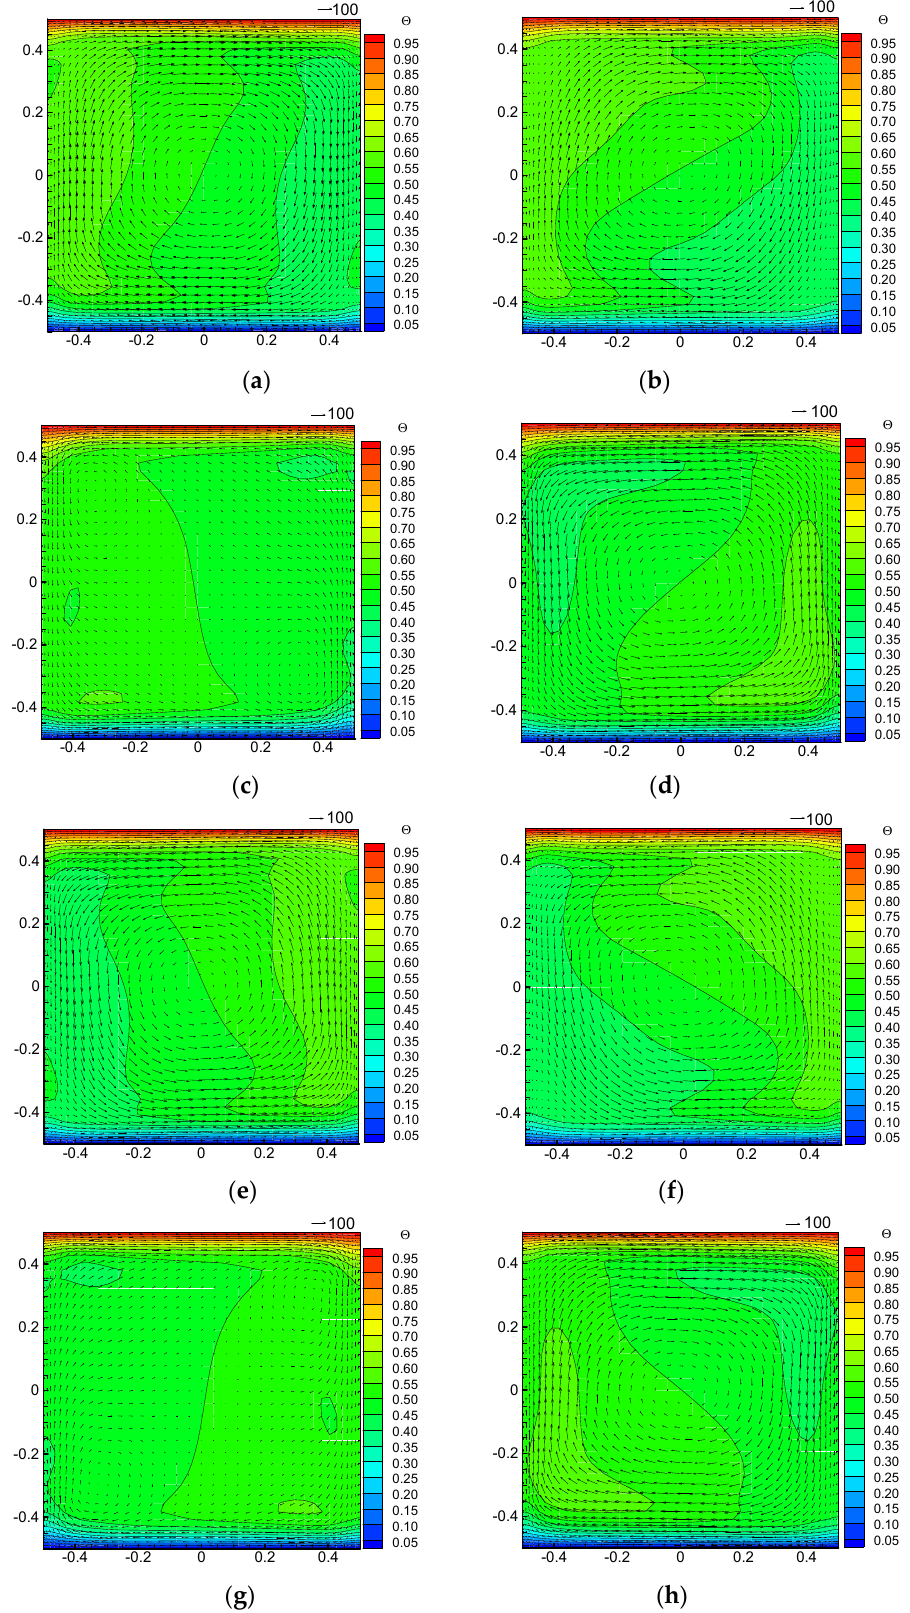
Figure 11. Temperature field evolution at x-o-z plane for Case 4: ( a ) ϕ = 0 (+) ; ( b ) ϕ = ϕ ( c ) ϕ = ϕ m ; ( d ) ϕ = ϕ m /2 ( − ) ; ( e ) ϕ = 0 ( − ) ; ( f ) ϕ = − ϕ m /2 ( − ) ; ( g ) ϕ = − ϕ m ; ( h ) ϕ = − ϕ m /2 (+)